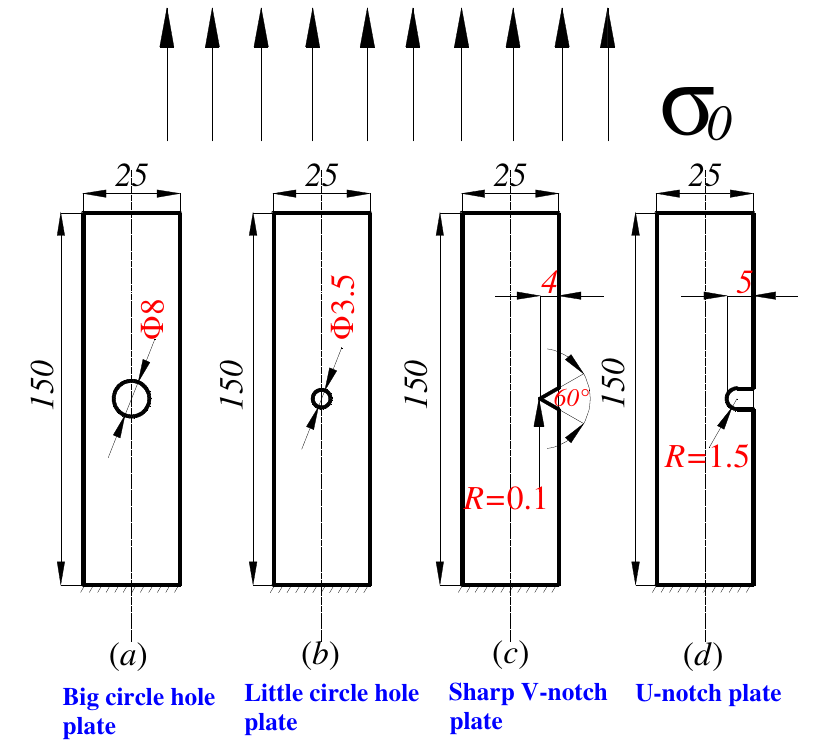
Figure 4. Geometries of different notched specimens (thickness = 6 mm, units: mm).